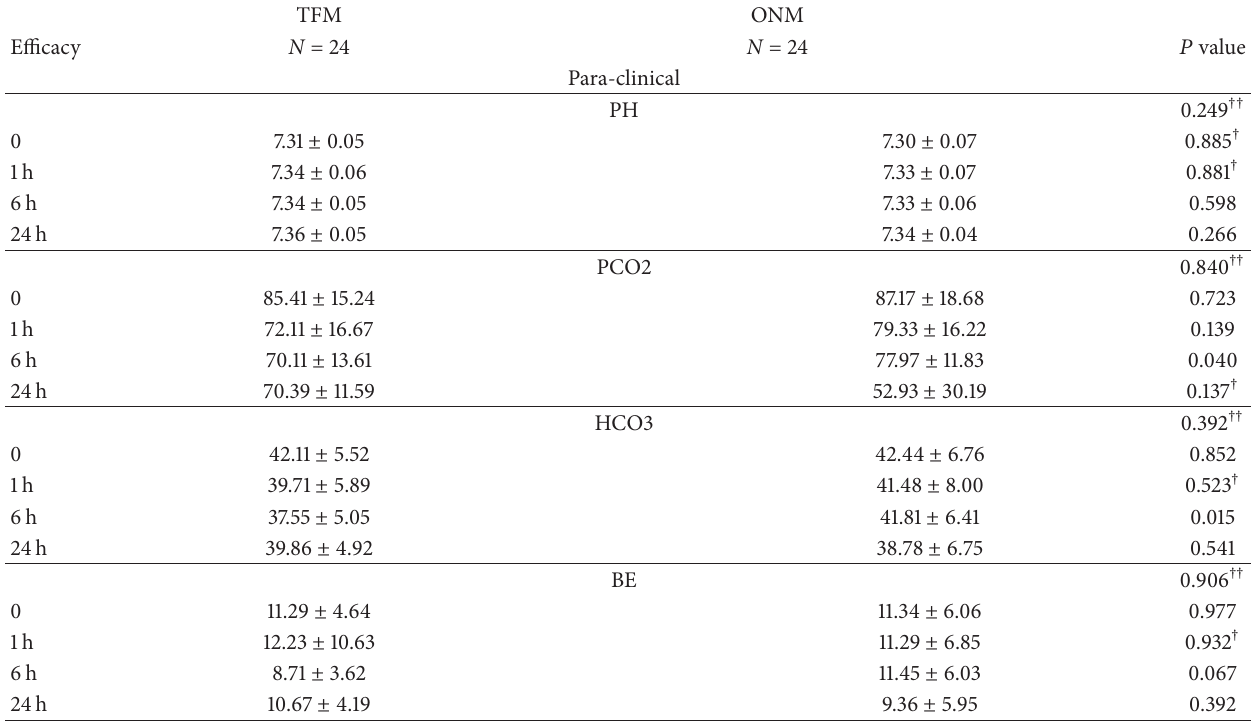
Table 3: Paraclinical parameters at one, six, and 24 hours after initiation of treatment.